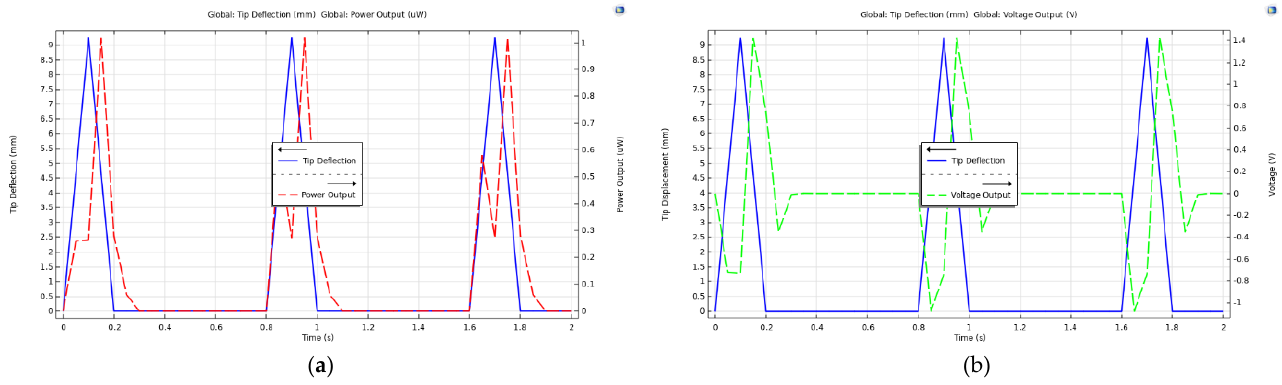
Figure 8. Electrical outputs for a cantilever tip displacement of the series connection bilayer piezo- electric energy harvesting pacemaker lead wire. Cantilever tip displacement is shown in both plots as solid-blue. ( a ) Power output (dashed-red). ( b ) Voltage Output (dashed-green).